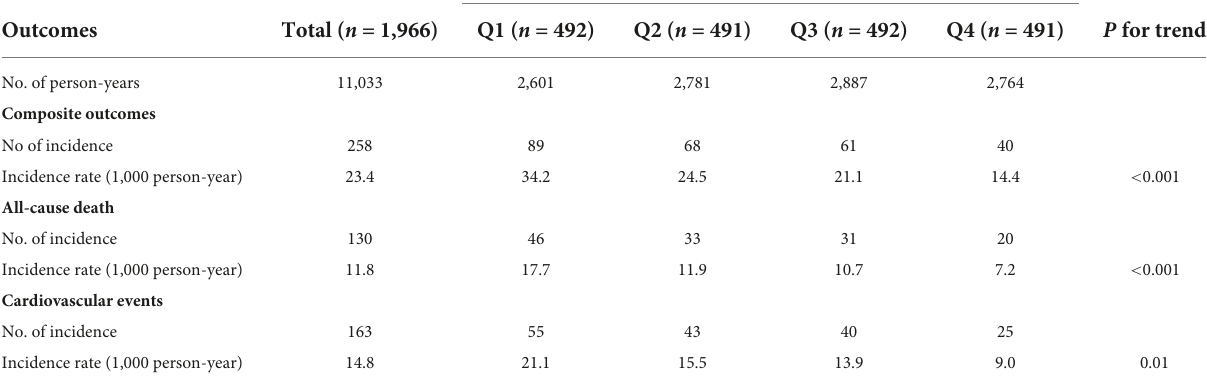
TABLE 2 Incidence of the composite outcomes, all-cause death, and cardiovascular events according to quartile of CysC/Cr ratio. Quartile of creatinine/Cystatin C